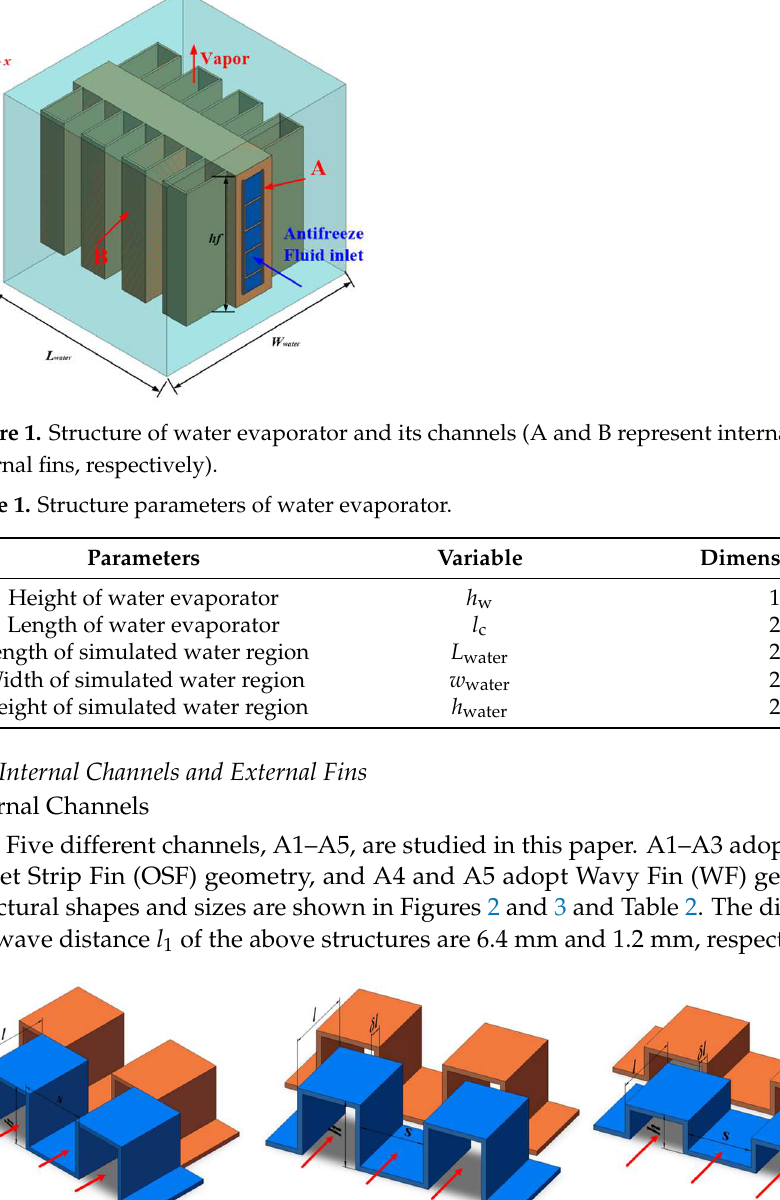
Figure 1. Structure of water evaporator and its channels (A and B represent internal channels and external fins, respectively) .